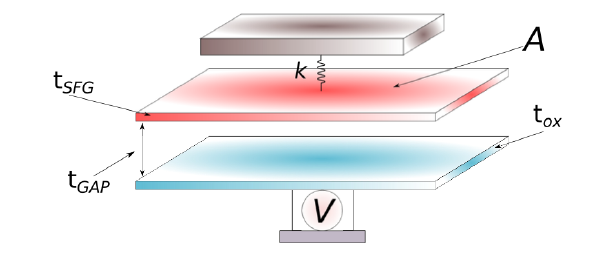
Figure 2. Double-plate capacitor structure model used to analyse the effects of the pull-in and pull-out effects, while a voltage is